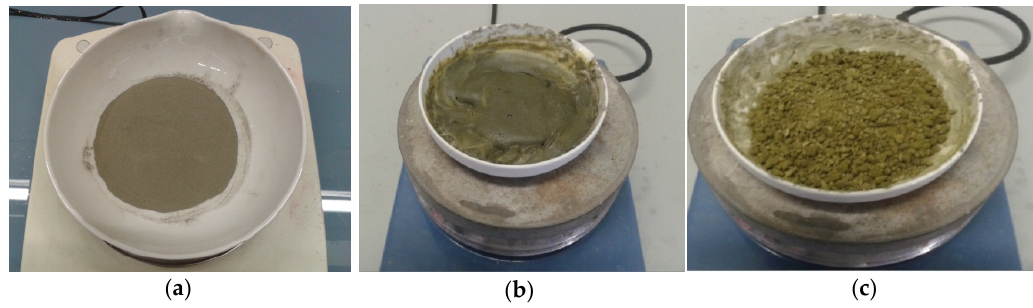
Figure 2. ( a ) Inital sample, ( b ) Conditioning of initial sample, ( c ) final product.